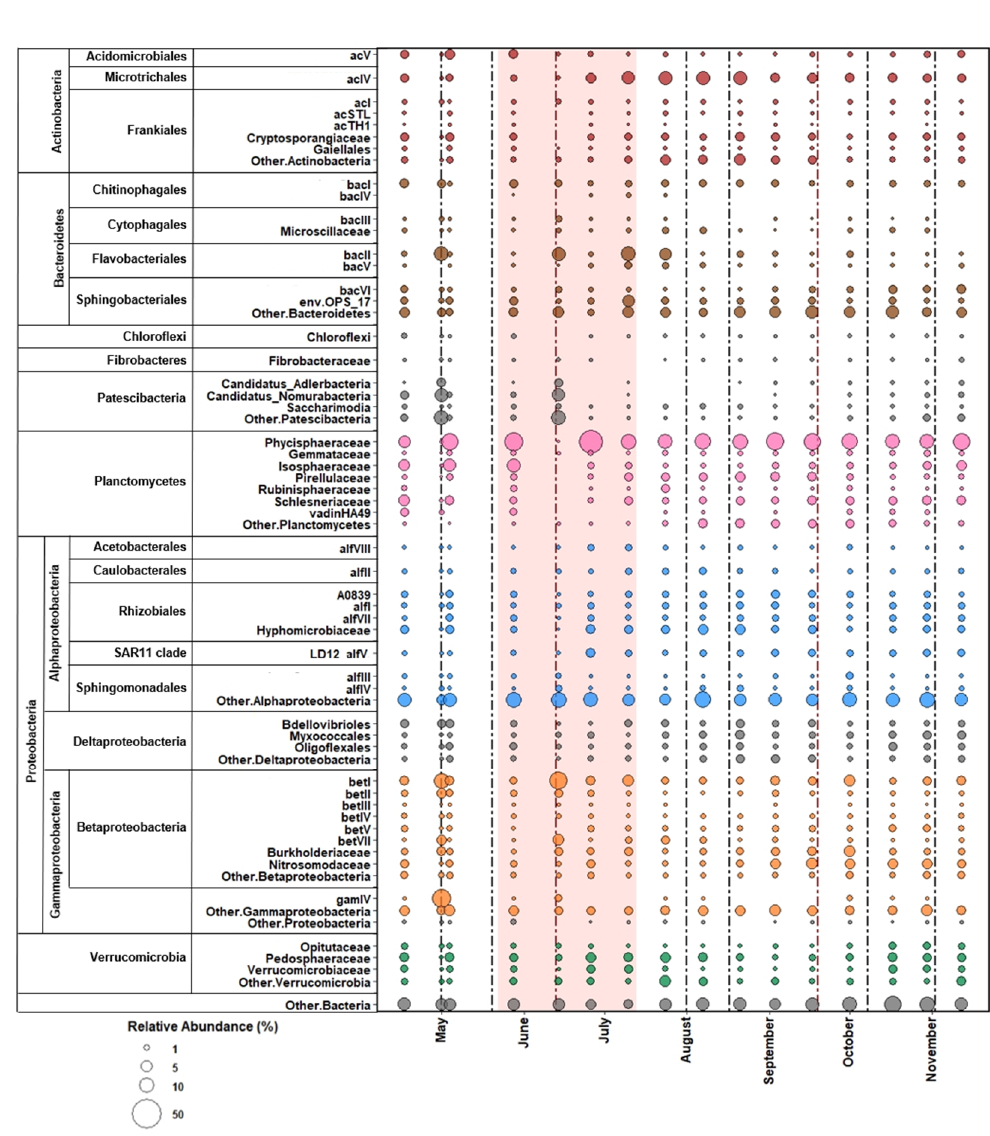
Figure 6. Bubble plot of the particle-associated bacterial abundance in Lough Feeagh. Dotted vertical lines indicate the onset of weather events. The pale red shaded area indicates the drought period.